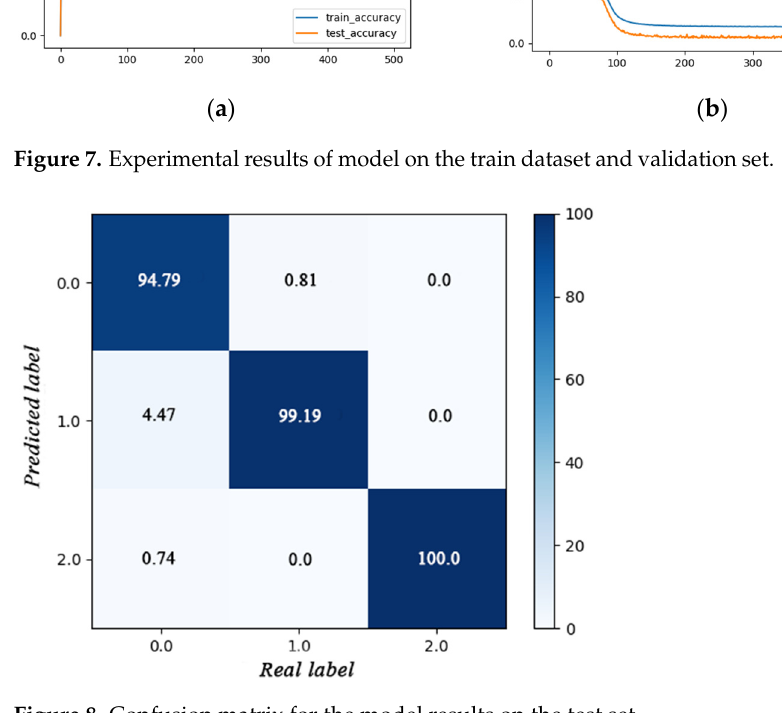
Table 4. Performance comparison between the proposed method and the benchmark methods.